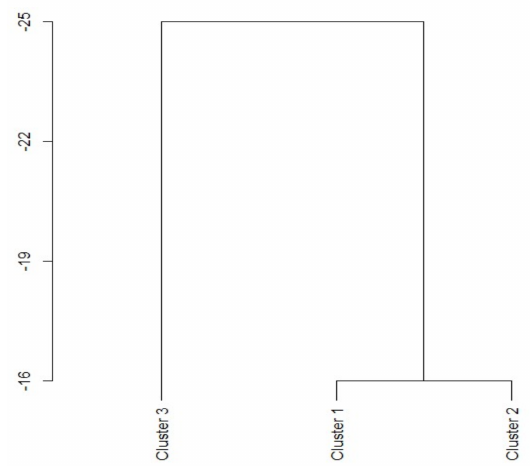
Figure 6. Similarity convergence for: (green) sum of exemplar preferences; (purple) sum of similarities to emplars; and (red) fitness (confirmation dataset).